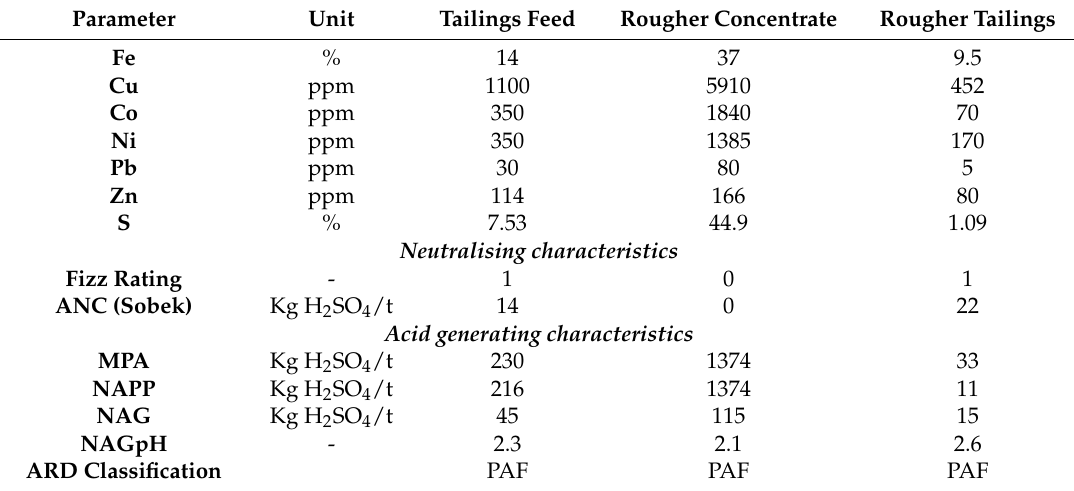
Figure 6. Bulk mineralogy (measured by X-ray diffractometry (XRD)) of the composite float feed, rougher concentrate (used in biooxidation experiments) and rougher tailings. Table 2. Chemical composition and geoenvironmental properties of composite head, rougher concentrate and rougher tailings (ANC: acid neutralizing capacity; MPA: maximum potential acidity; NAPP: net acid producing potential calculated by MPA-ANC; NAG: net acid generation; PAF: potentially acid